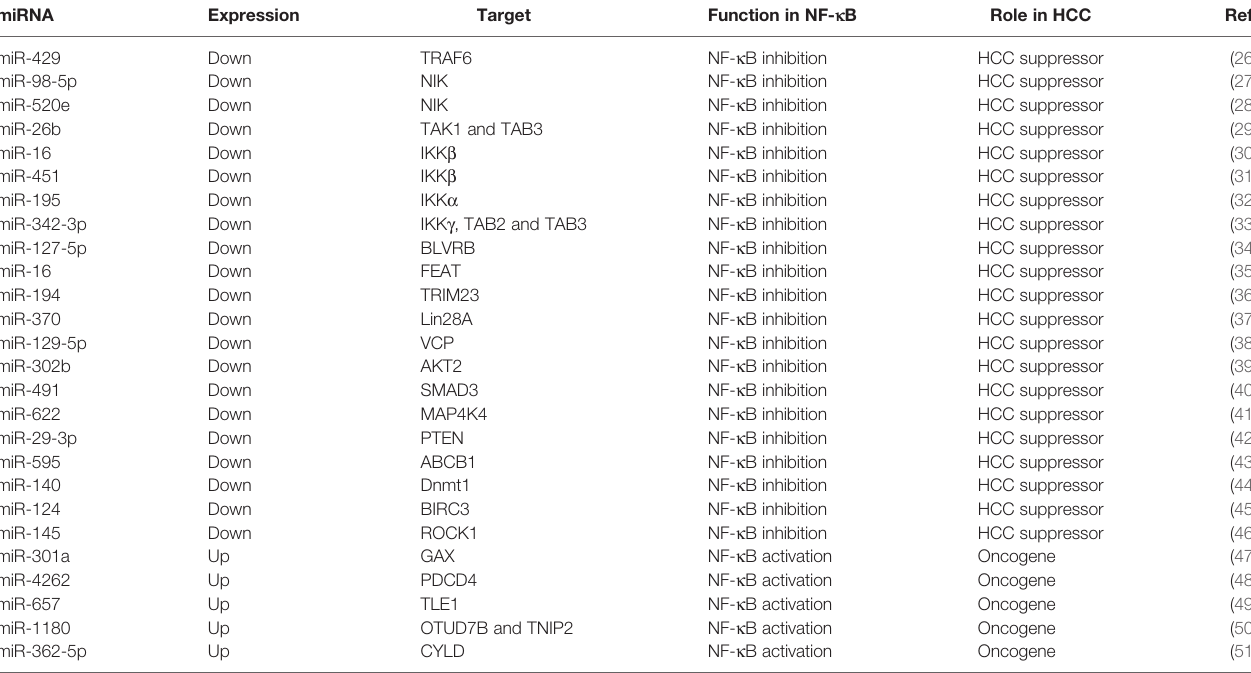
TABLE 1 | miRNAs involved in the regulation of NF- k B pathway and/or NF- k B activity in HCC.